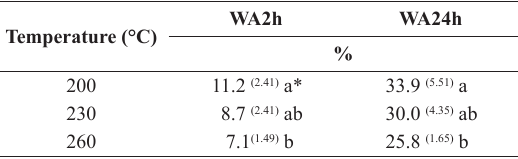
Table 4. Mean values of water absorption as a function of temperature.